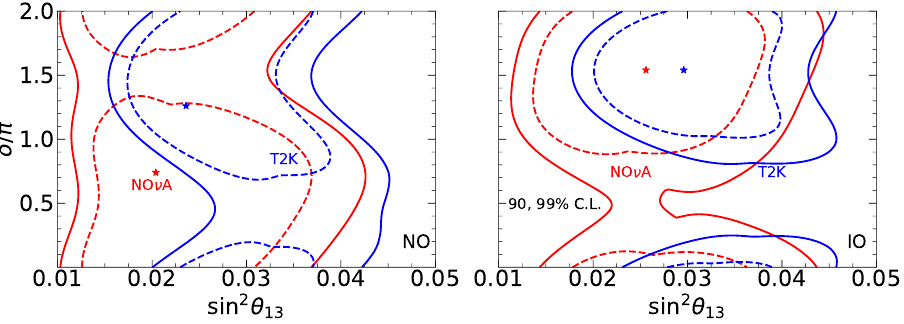
Figure 4 . 90 and 99% C.L. (2 d.o.f.) allowed regions in the sin 2 θ 23 – ∆ m 2 IO (right), obtained from the analyses of T2K (blue), NO ν A (red) and MINOS (green) data. The best fit values are indicated by stars.